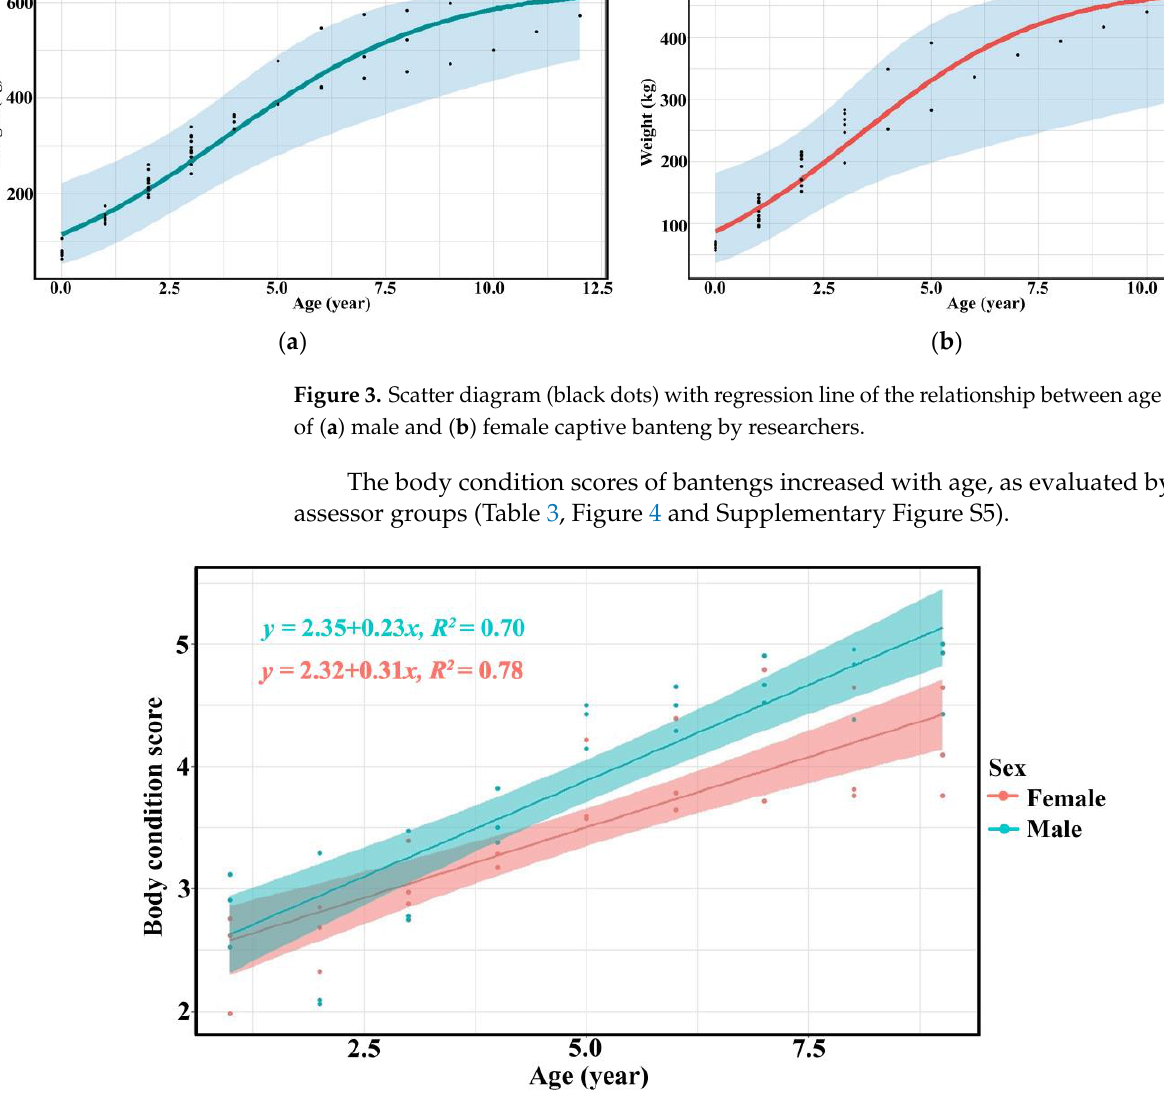
Figure 4. Relationship between age and body condition score of male (green) and female (red) captive bantengs by researchers.